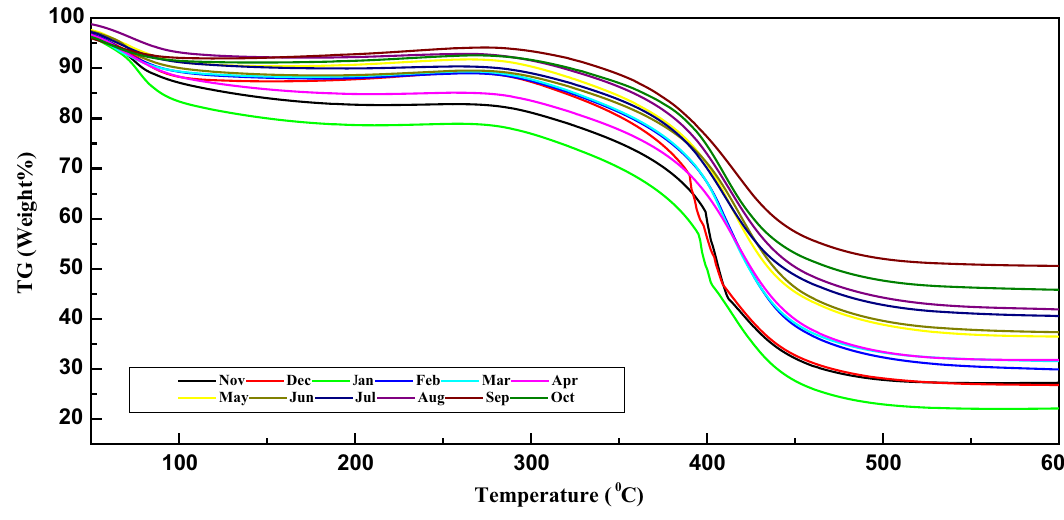
Fig. 6 TGA curves of coal with seasonal